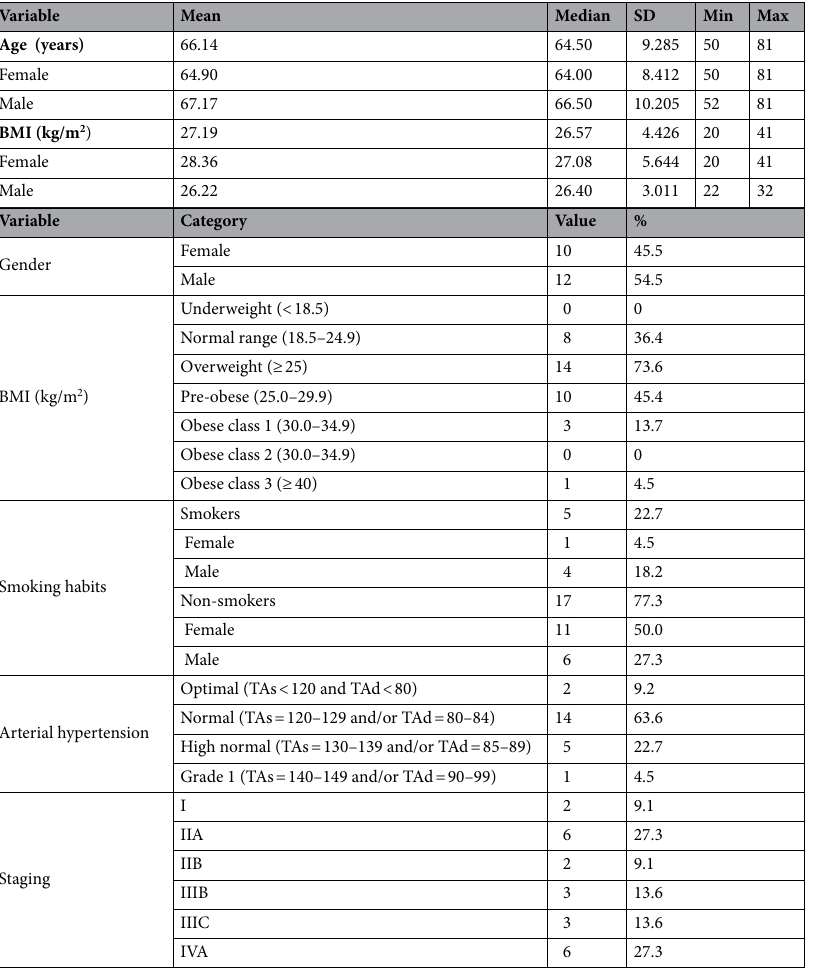
Table 1. Clinical, demographic and staging data of the study